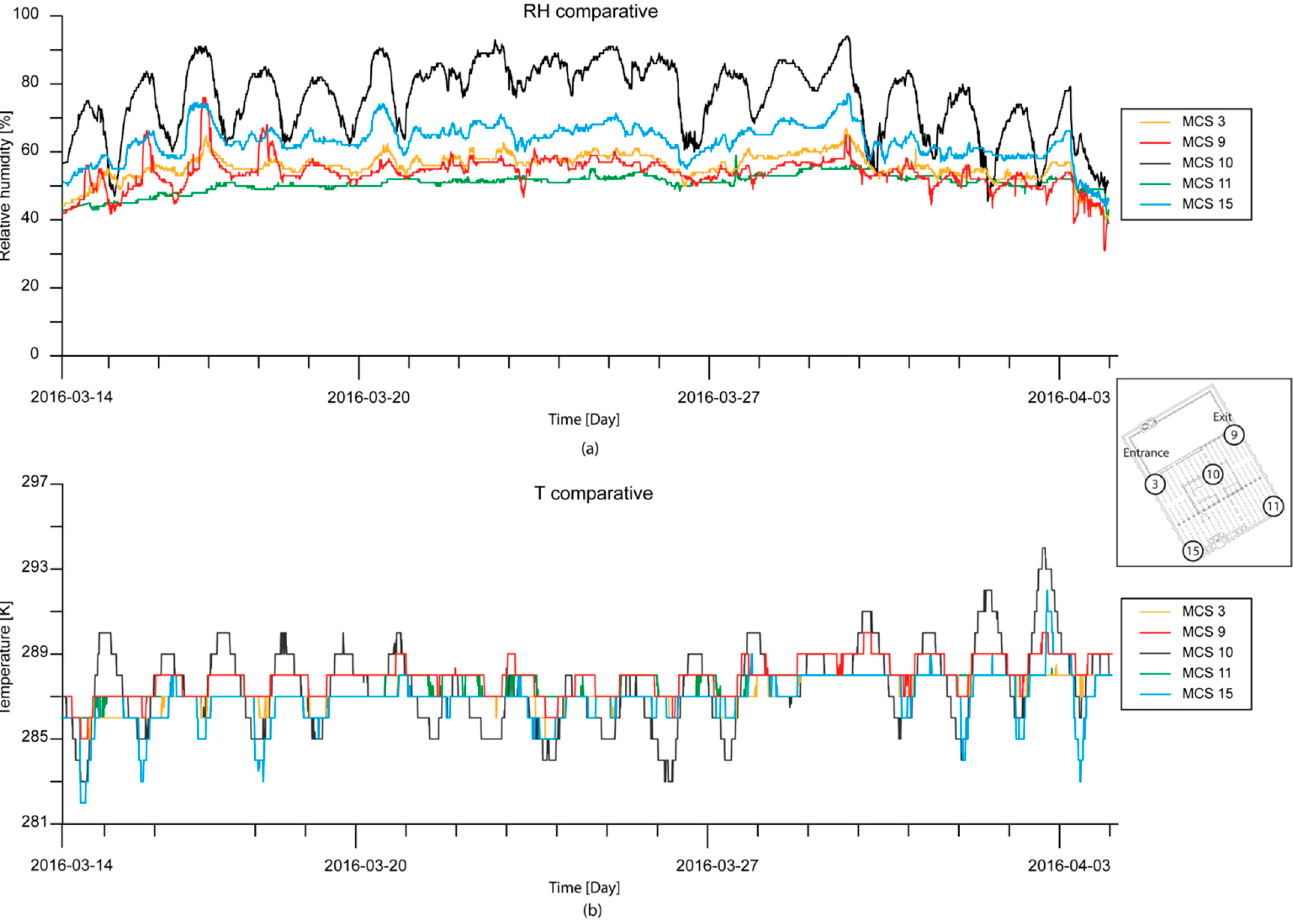
Figure 6. Example time series graph comparing the evolution of ( a ) RH and ( b ) T of the exterior weather conditions (MCS 10) and interior microclimate conditions of the Mosque-Cathedral (MCSs 3, 9, 11, and 15).